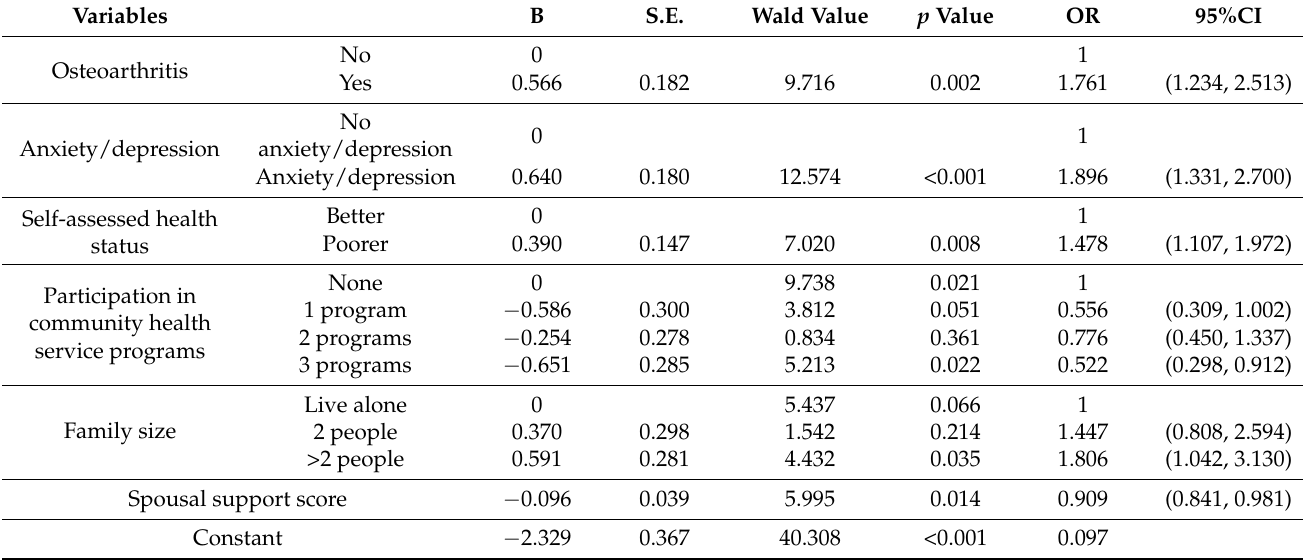
Table 2. Multivariate analysis of falls in the elderly ( n =